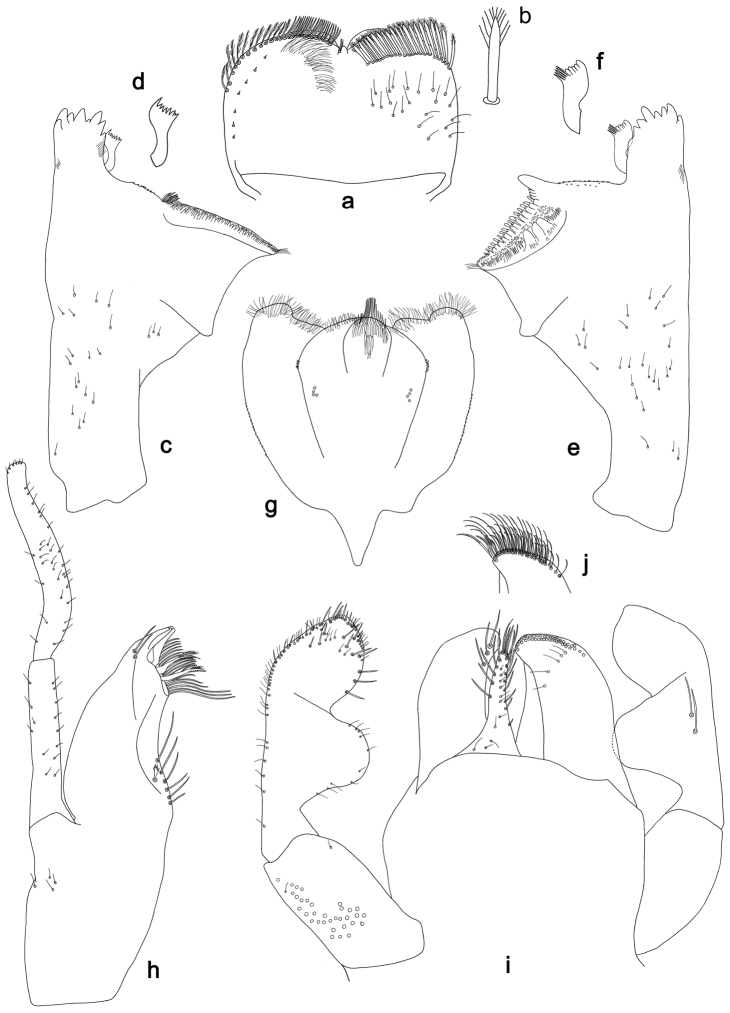
Labiobaetisinopinatus sp. n., larva morphology: a Labrum b Labrum dorsal, submarginal seta c Right mandible d Right prostheca e Left mandible f Left prostheca gHypopharynxh Maxilla i Labium.